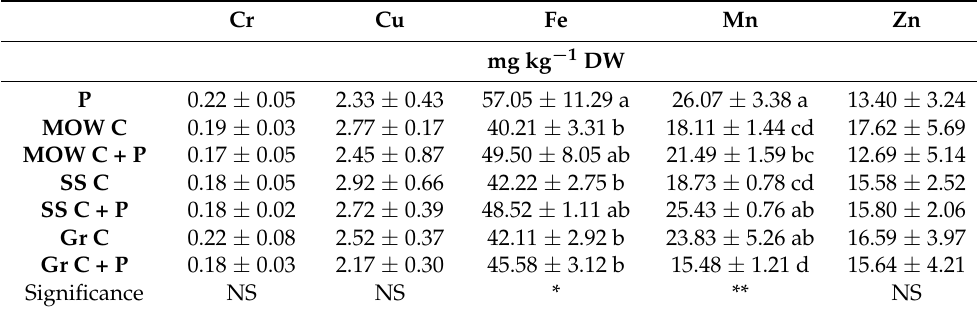
Table 4. Trace metals tissue concentration of sea fennel grown on seven substrates composed of peat and three different composts containing posidonia residues. A peat − based commercial substrate was used as control. The compost materials were tested alone or in mixture with peat (at a rate of 50% on a volume basis). Cr